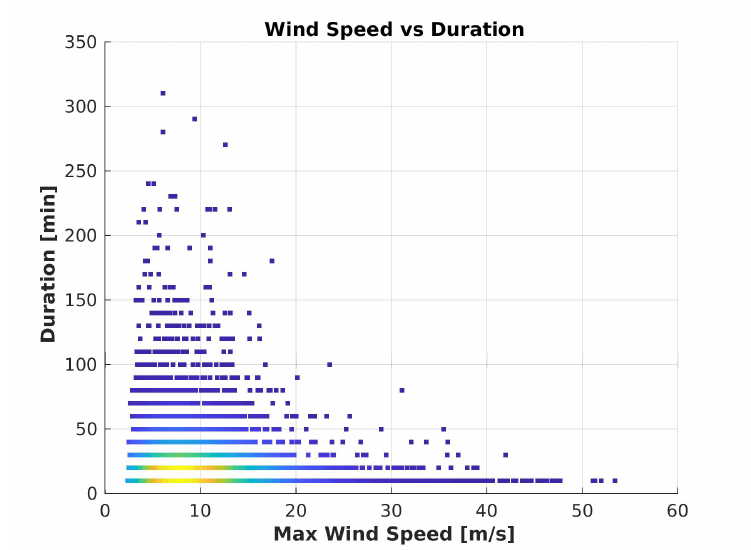
Figure 13. Dependency between maximum wind speed and the duration of the events. The colour indicates the relative number of events (blue: least, yellow: max, in arbitrary units). All gusts are pictured here at t = 10 min, LJ start at t 100 min. In between all intermediate jets are plotted. ≥